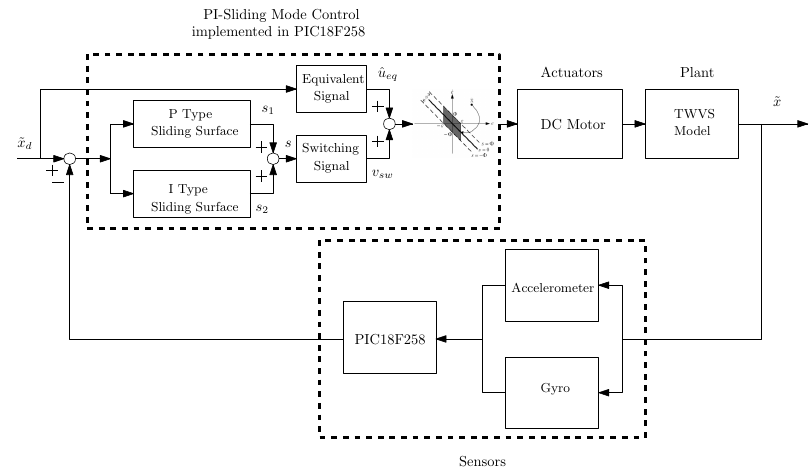
Figure 8. A block diagram of the overall